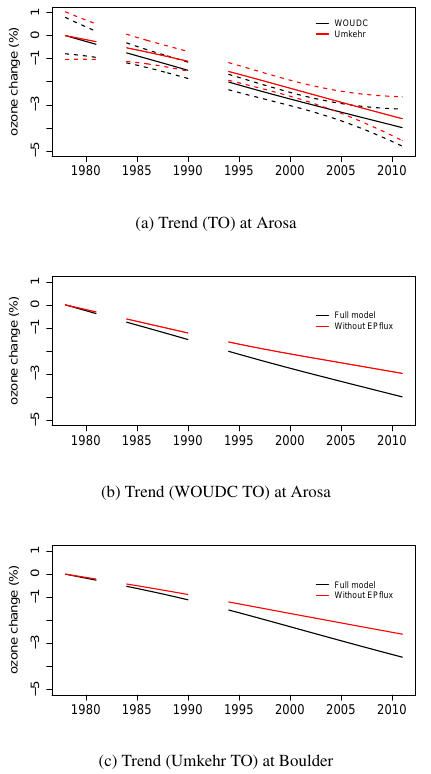
Fig. 18. Estimated trends for total column ozone at Arosa. (a) Ozone trends for Umkehr (in red solid line) and WOUDC (in black solid line) TO, with their 95% confidence intervals in dotted lines with the matching color. (b) Ozone trends for WOUDC TO obtained from the full regression model (in black) and the model without EP flux (in red). (c) Ozone trends for Umkehr TO obtained from the full regression model (in black) and the model without EP flux (in red).